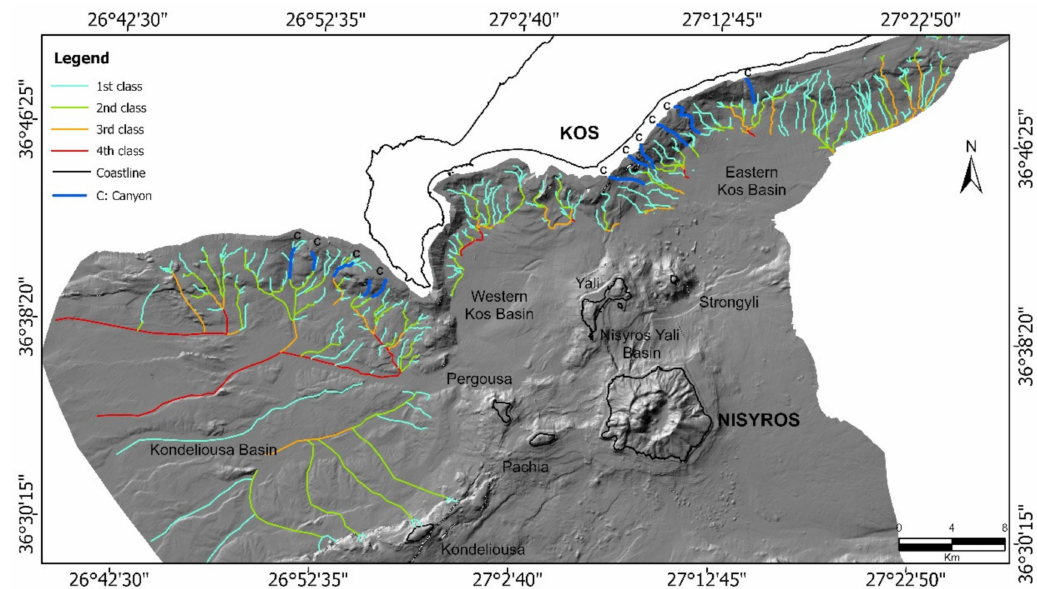
Figure 11. The submarine drainage network along the southern continental slopes of Kos Island, ending into the three submarine basins of Kondeliousa, Western Kos and Eastern Kos. The submarine drainage has been categorized according to Strahler technique. Canyons (c) are also distinguished usually developed in 1st or 2nd order